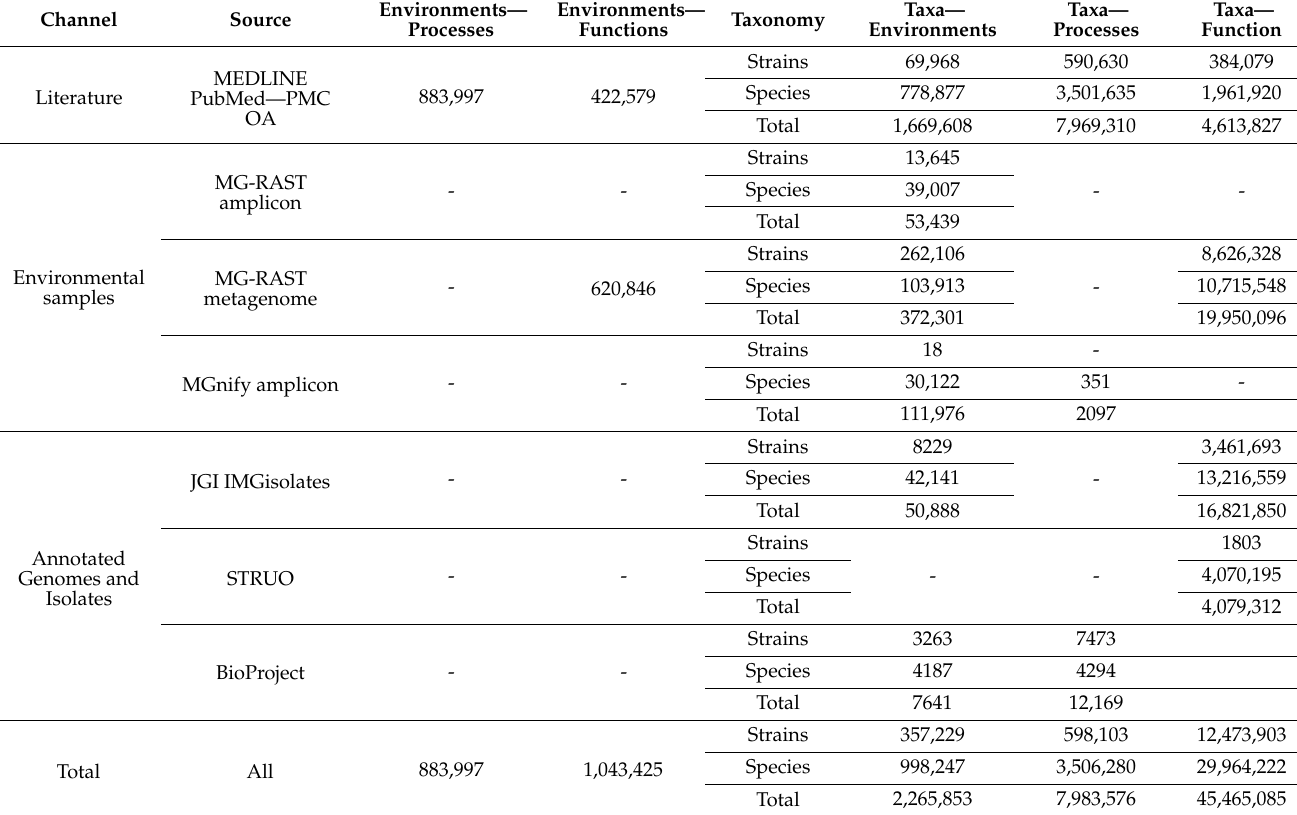
Table 3. The associations between entities of PREGO after co-occurrence analysis: The supported entity types of associations are Environments—Biological Processes, Environments—Molecular Functions, Taxa—Environments, Taxa—Biological Processes, Taxa—Molecular